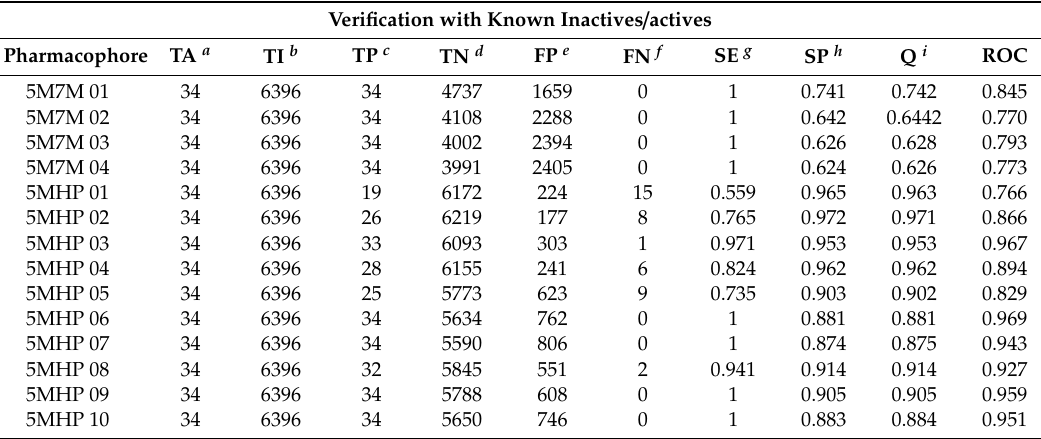
Table 2. The verification results of pharmacophore models 5MHP 01–10 and 5M7M 01–04. Verification with Known Inactives /